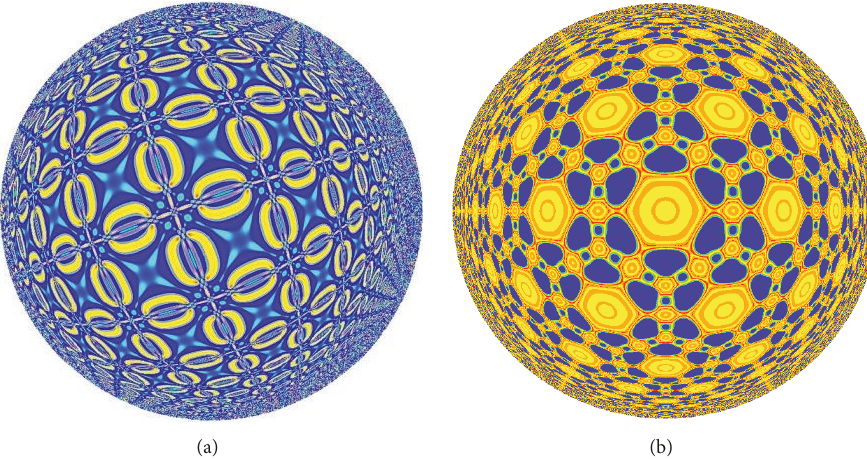
Figure 4: Colorful spherical wallpaper patterns with the 𝑝4𝑚 (a) and 𝑝6𝑚 (b)